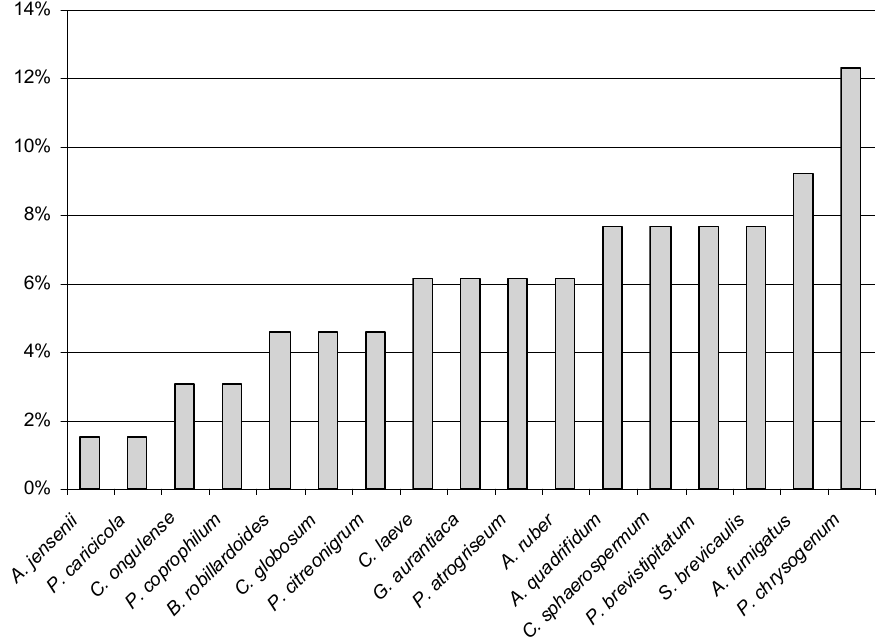
Figure 2. The percentage of which each species was isolated from the wing membranes of 12 female greater mouse-eared bats ( Myotis myotis ) contributed to the total from all incubation temperatures.